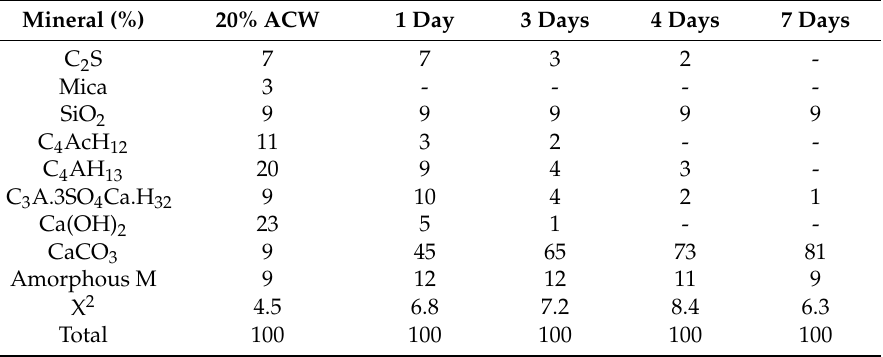
Table 4. Rietveld-refined mineralogical composition of 28 days cured 20% ACW by time of exposure to accelerated carbonation.